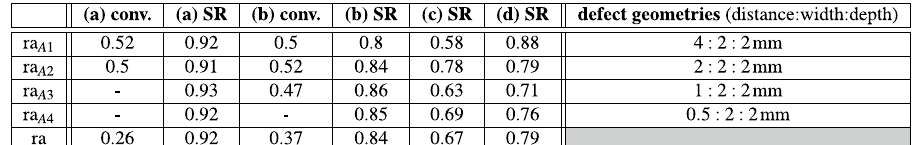
Table 2. Calculated reconstruction accuracies ra shown result in Fig. 6, A 1 indicates the area of the defect pair with the largest distance to each other and A 4 the defect pair area with the shortest distance to each other. Table cells with a dash inside mean that it was not possible to identify two defects. The defect geometries in the last column are speciefied by the distance between two defects within a defect pair, the width of one defect (all defects have the same width) and the depth of the defects (all defects have the same depth). A graphical visualization of the investigated defect geometries is shown in Fig.